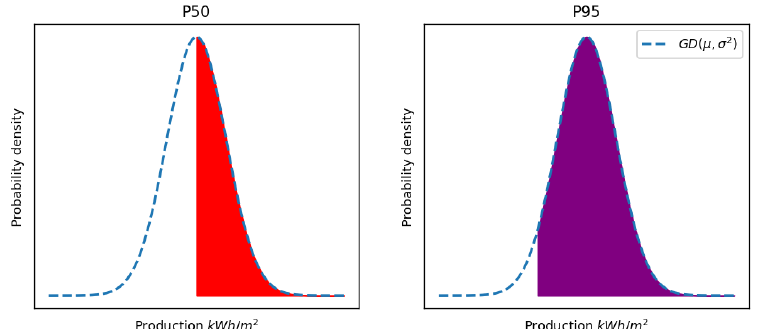
Figure 4. Gaussian distributions with the P 50 and P 95 estimations are shown in the left and right figures, respectively.